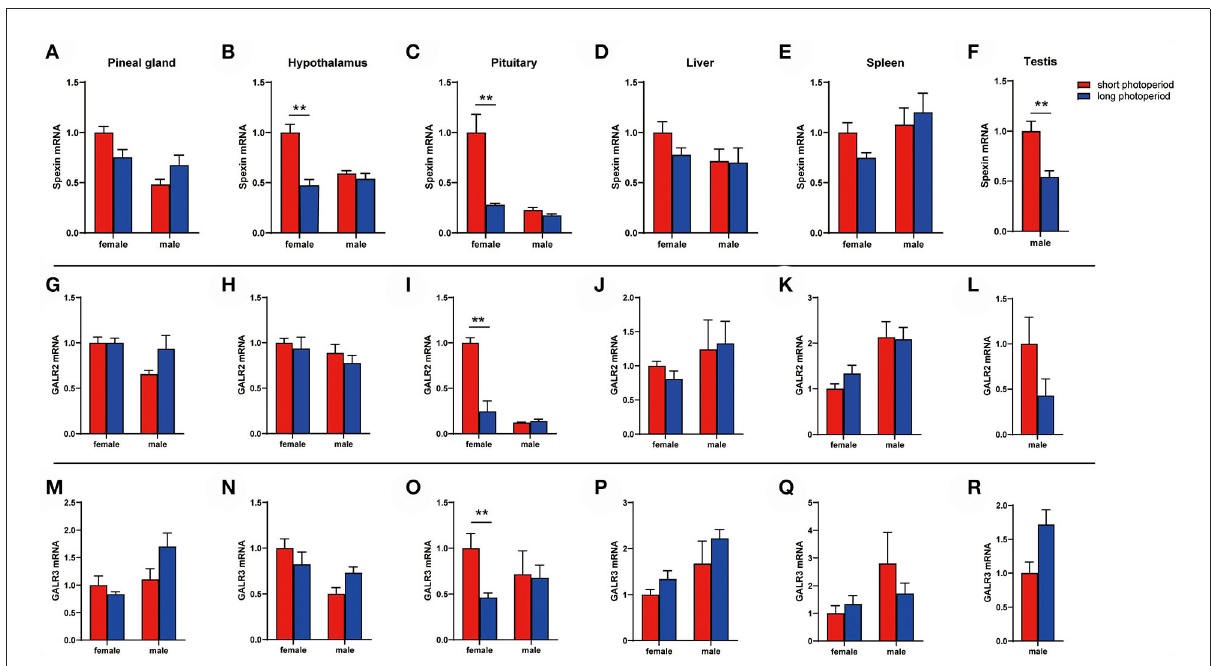
FIGURE4 Spexin and GALR2/3 expression during different photoperiods. (A,G,M) Gene expression level in pineal gland. (B,H,N) Gene expression level in hypothalaus. (C,I,O) Gene expression level in pituitary. (D,J,P) Gene expression level in liver. (E,K,Q) Gene expression level in spleen. (F,L,R) Gene expression level in testis. Data are expressed as mean ± SEM ( n = 3). ** P < 0.05.